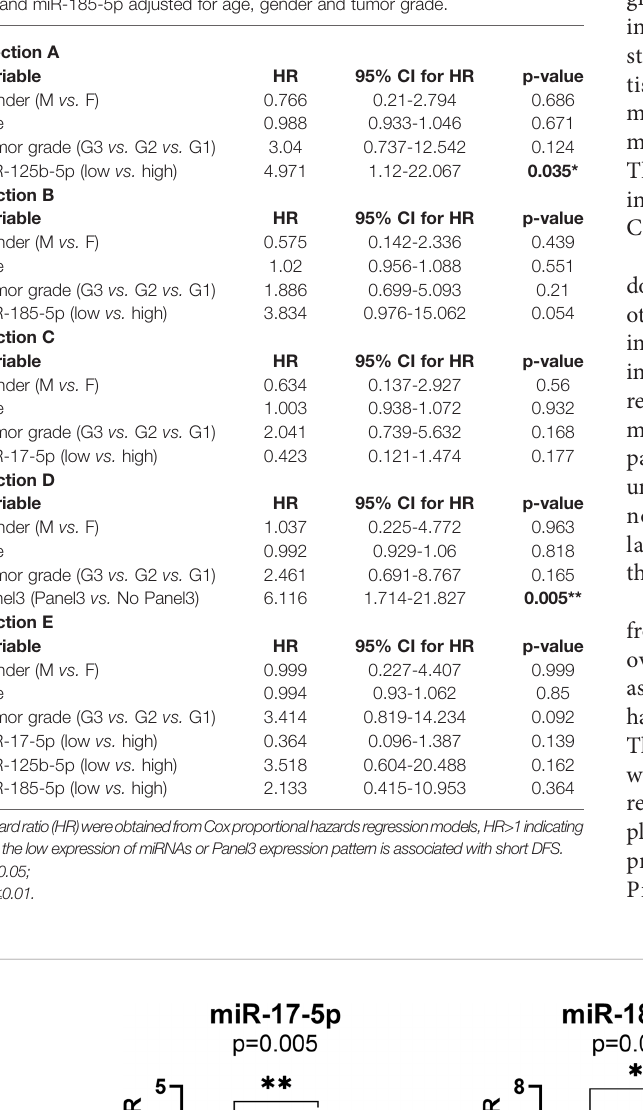
TABLE 4 | Multivariate survival analysis of (Section A) miR-125b-5p; (Section B) miR-185-5p; (Section C) miR-17-5p; (Section D) Panel3 expression pattern (high tissue miR-17-5p expression & low tissue miR-125b-5p expression & low tissue miR-185-5p expression); (Section E) combined effect of miR-17-5p, miR-125b- 5p and miR-185-5p adjusted for age, gender and tumor grade.